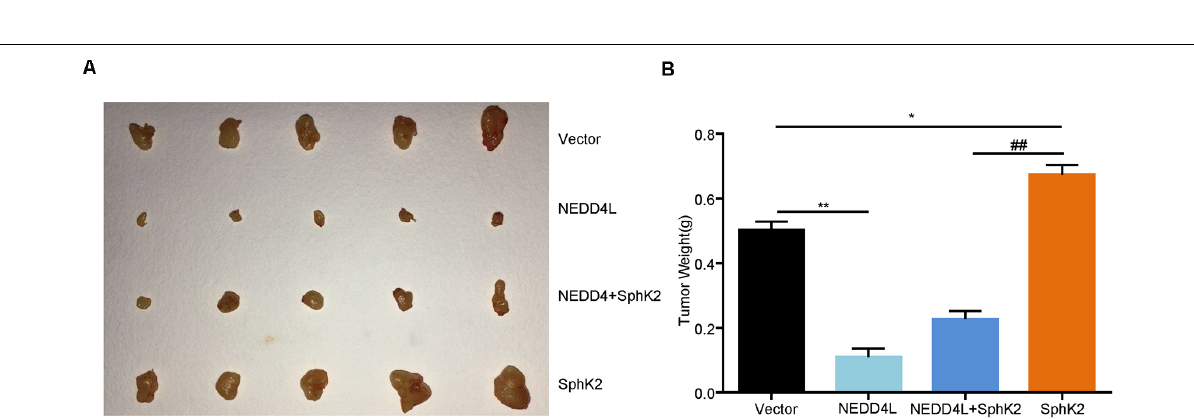
FIGURE 6 | Ubiquitination of SphK2 inhibits glioma growth in vivo . (A,B) Glioma U251 cells stably overexpressed of NEDD4L and/or SphK2 were implanted into 5-week-old female nude mice, and tumor weight was measured 21 days after injection. * P < 0.05, ** P < 0.01 compared with the vector; ## P < 0.01 compared with SphK2 overexpression